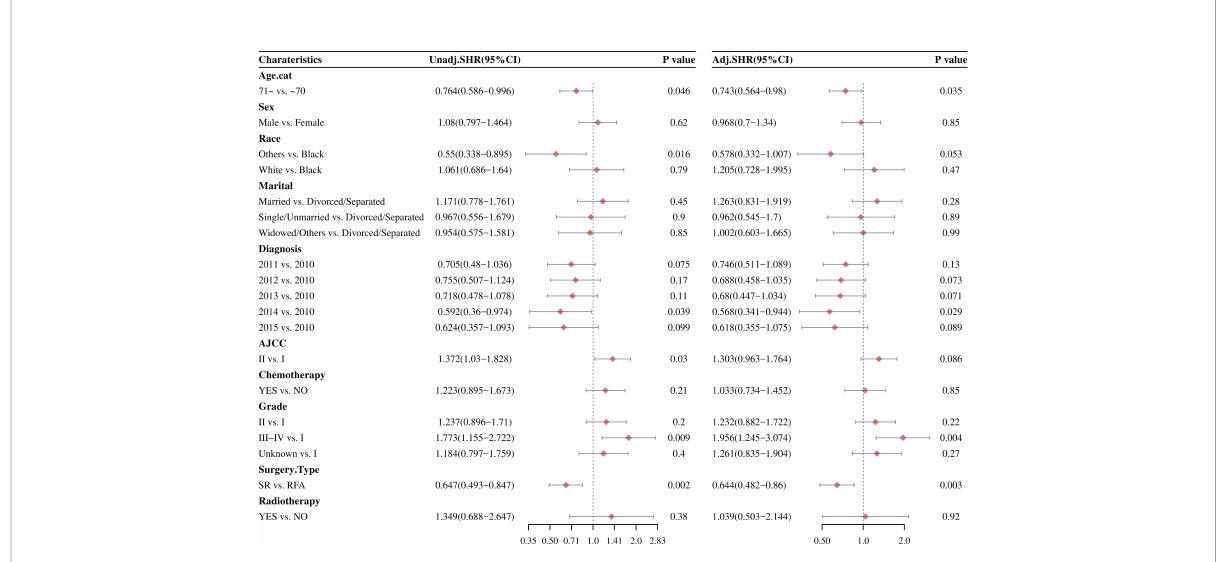
FIGURE 8 Forestplot of OS and DSS were analyzed by the univariate Cox proportional hazard models after CIF analysis after